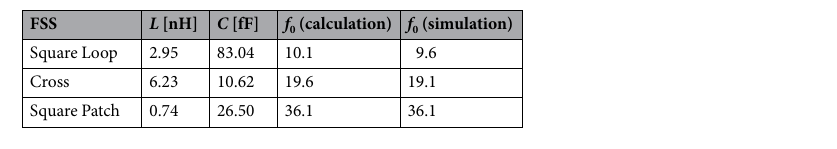
Table 2. Circuit parameters ( L , C ) and resonance frequencies of